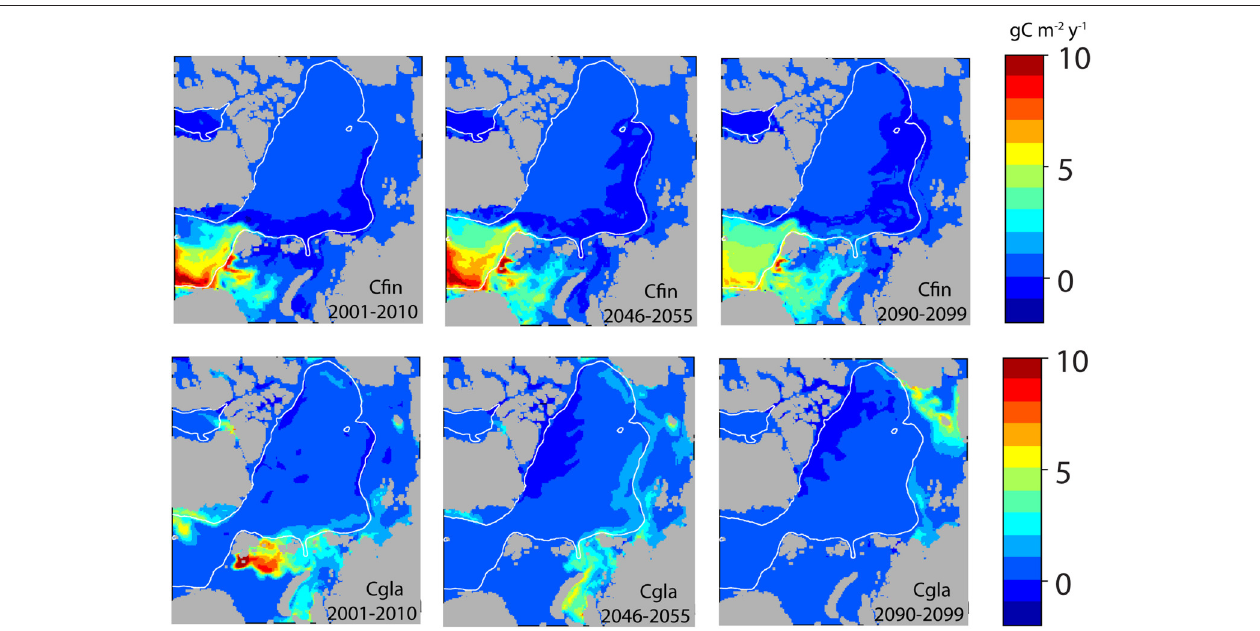
FIGURE 9 | Simulated 10 year mean annual production of the zooplankton key species Calanus finmarchicus (Cfin, upper line) and Calanus glacialis (Cgla lower line) in the entire Arctic Ocean (A1B) at present (2001–2010), in 2046–2055 and 2090–2099 (g C m − 2 y − 1